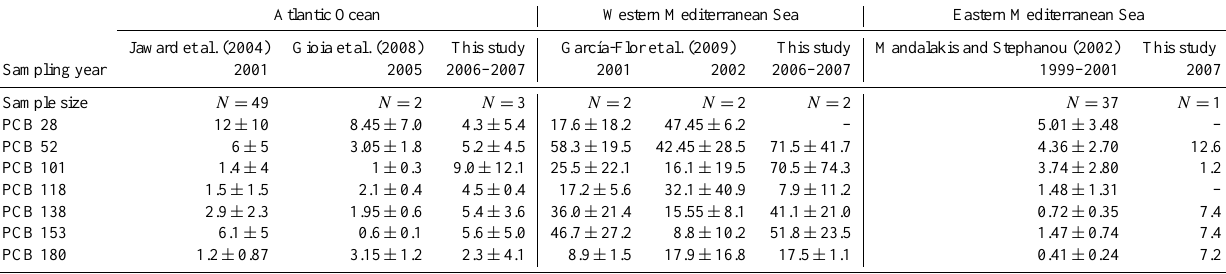
Table 2. Comparison of the gas-phase concentrations of the seven ICES PCB congeners in different locations of Mediterranean and Black Sea (mean ±SD) obtained in the present study with those reported previously. Atlantic Ocean Western Mediterranean Sea Eastern Mediterranean Sea Jaward et al. (2004) Gioia et al. (2008) This study García-Flor et al.